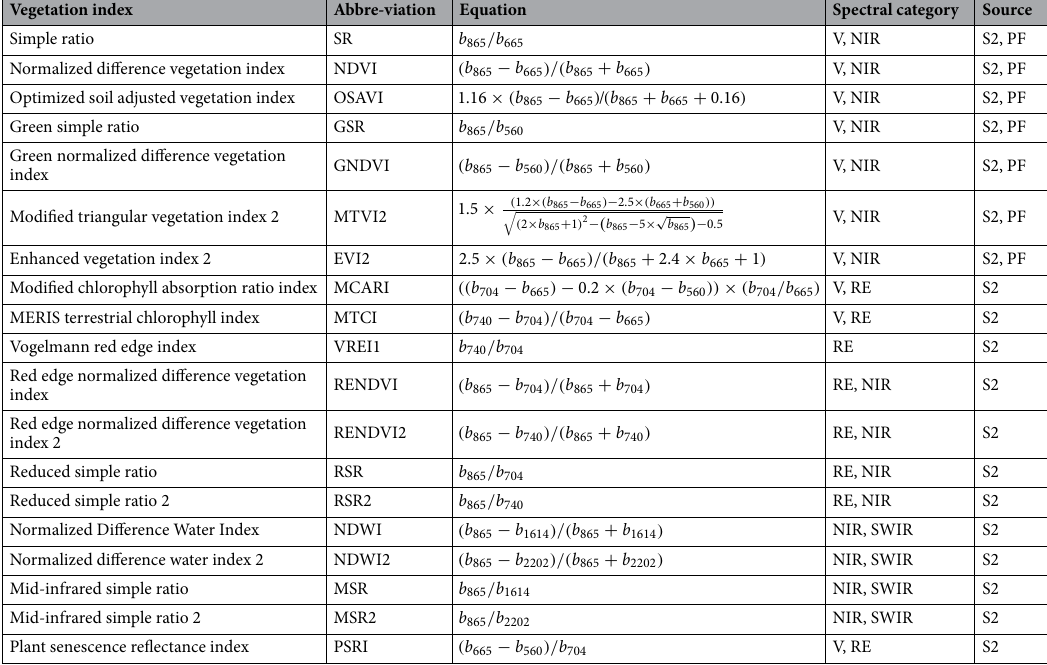
Table 1. List of vegetation indices across the visible (V), red-edge (RE), near infrared (NIR), and shortwave infrared (SWIR) domains used in the training of the random forest (Sentinel-2) and Cubist (Sentinel-2 and Planet Fusion) based leaf area index prediction models. The indicated spectral wavelengths represent the center of the corresponding Sentinel-2 band. Note that the four Planet Fusion bands were identical to the Sentinel-2 bands as the bands were aligned during the Planet Fusion radiometric harmonization